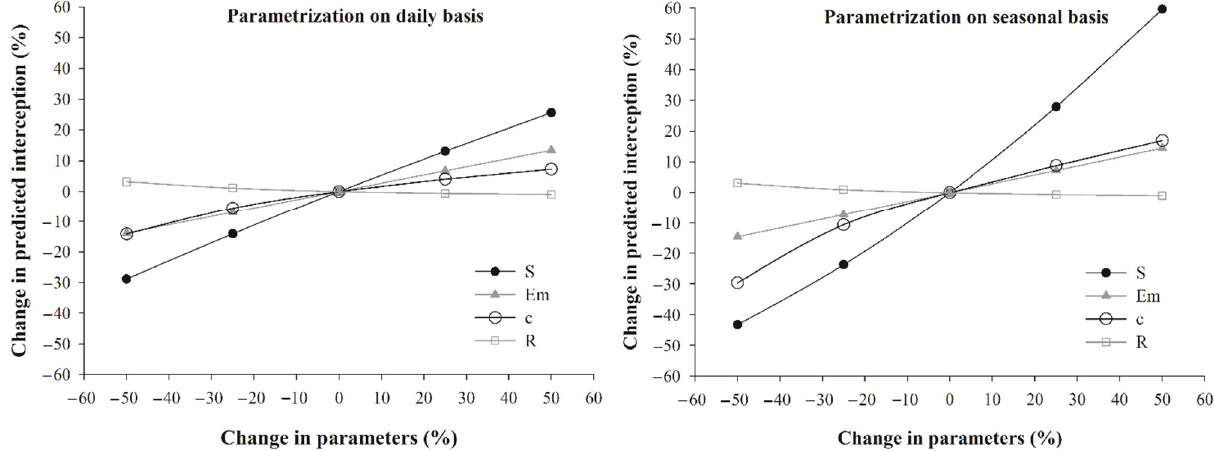
Figure 4. Sensitivity analysis of the Gash model parametrized on daily and seasonal bases applied to the Caatinga domain in Brazil.